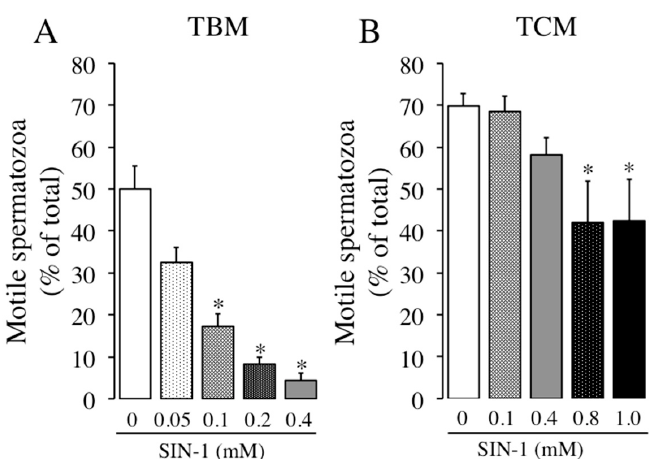
Figure 1. E ff ects of 3-morpholinosydnonimine (SIN-1) induced-peroxynitrite in the percentage of motile Figure 1. Effects of 3 ‐ morpholinosydnonimine (SIN ‐ 1) induced ‐ peroxynitrite in the percentage of spermatozoa. Boar spermatozoa were incubated in non-capacitating media (TBM) ( A ) or capacitating motile spermatozoa. Boar spermatozoa were incubated in non ‐ capacitating media (TBM) ( A ) or media (TCM) ( B ) at 38.5 ◦ C in the absence (white histograms) or presence of di ff erent concentrations of capacitating media (TCM) ( B ) at 38.5 °C in the absence (white histograms) or presence of different SIN-1 (0.05-1 mM, filled histograms) for 1 h. The percentage of motile spermatozoa was evaluated by concentrations of SIN ‐ 1 (0.05 ‐ 1 mM, filled histograms) for 1 h. The percentage of motile spermatozoa ISAS ® system. This experiment was performed 8 times ( n = 8) and results are expressed as the mean was evaluated by ISAS ® system. This experiment was performed 8 times ( n = 8) and results are of the percentage of total spermatozoa ± standard error of the mean (SEM). Statistical di ff erences are expressed as the mean of the percentage of total spermatozoa ± standard error of the mean (SEM). shown with * ( p < Statistical differences are shown with * ( p < 0.05).